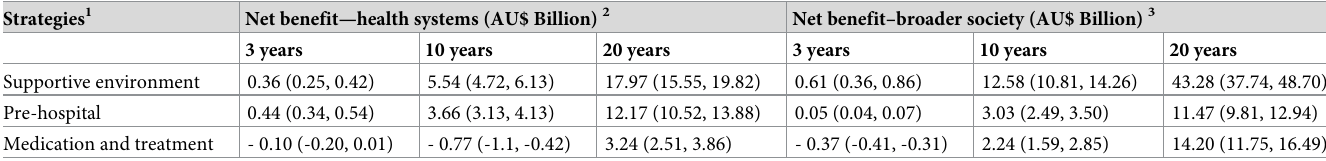
Table 2. Economic outcomes of three types of strategies and their interquartile ranges at 3, 10, and 20 years. Strategies